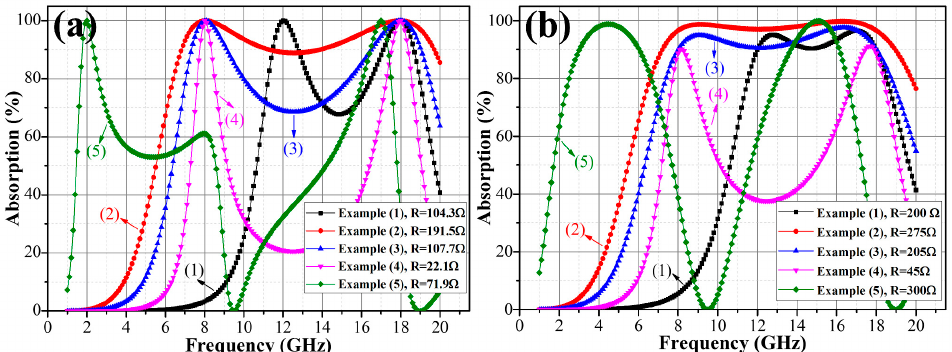
Figure 4. The absorption performances of example absorbers with ( a ) R calculated using Equation (6) and ( b ) optimized R . Table 2. The parameter details of design examples in Figure 4.